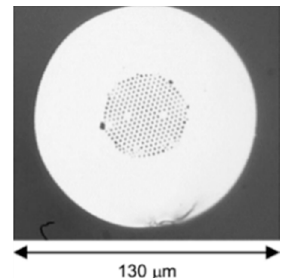
Figure 21. Microscopic image of the curved end face of a two core PCF. These two cores help in forming a two-beam interferometer and curvature is measured using the phase difference between two beams (Reproduced from [86], with the permission of Elsevier publishing).